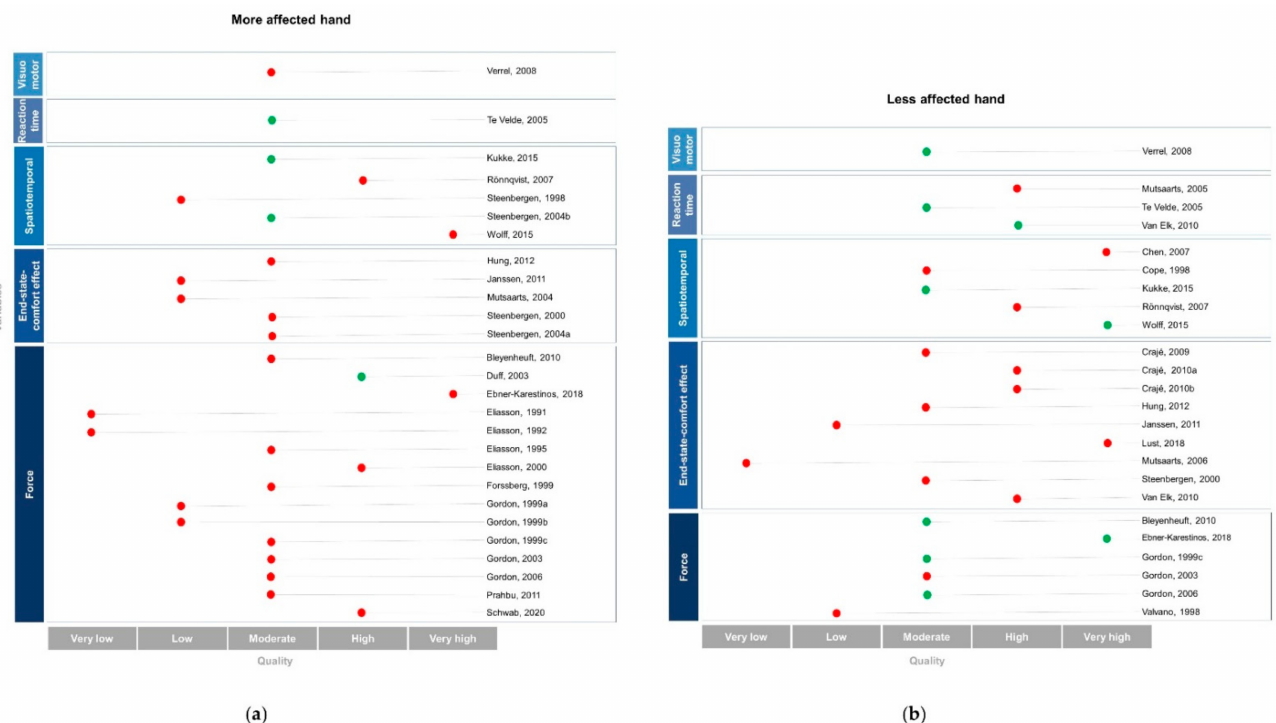
Figure 3. Study results for each upper limb according to the motor planning variables assessed and the quality of the study. The ( a ) panel presents data for the more affected hand, and the ( b ) panel for the less affected hand. The studies are classified by motor planning variables (Y-axis) and by level of study quality (X-axis). The red dots represent studies that found motor planning deficits and the green dots indicate results of unaffected motor planning as compared to TD children or similar performance between the less affected hand and the more affected